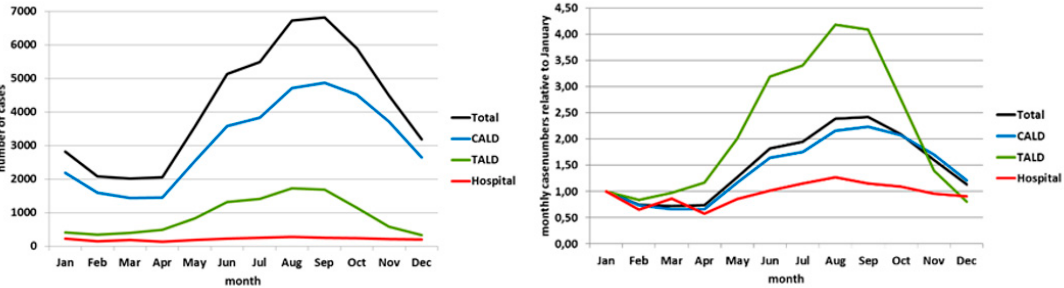
Figure 2. Left panel: absolute case numbers by month, age group and exposure category; Germany, pooled data 2005–2015. Right panel: relative case numbers (relative to January) by month, age group and exposure category; Germany, pooled data 2005–2015.